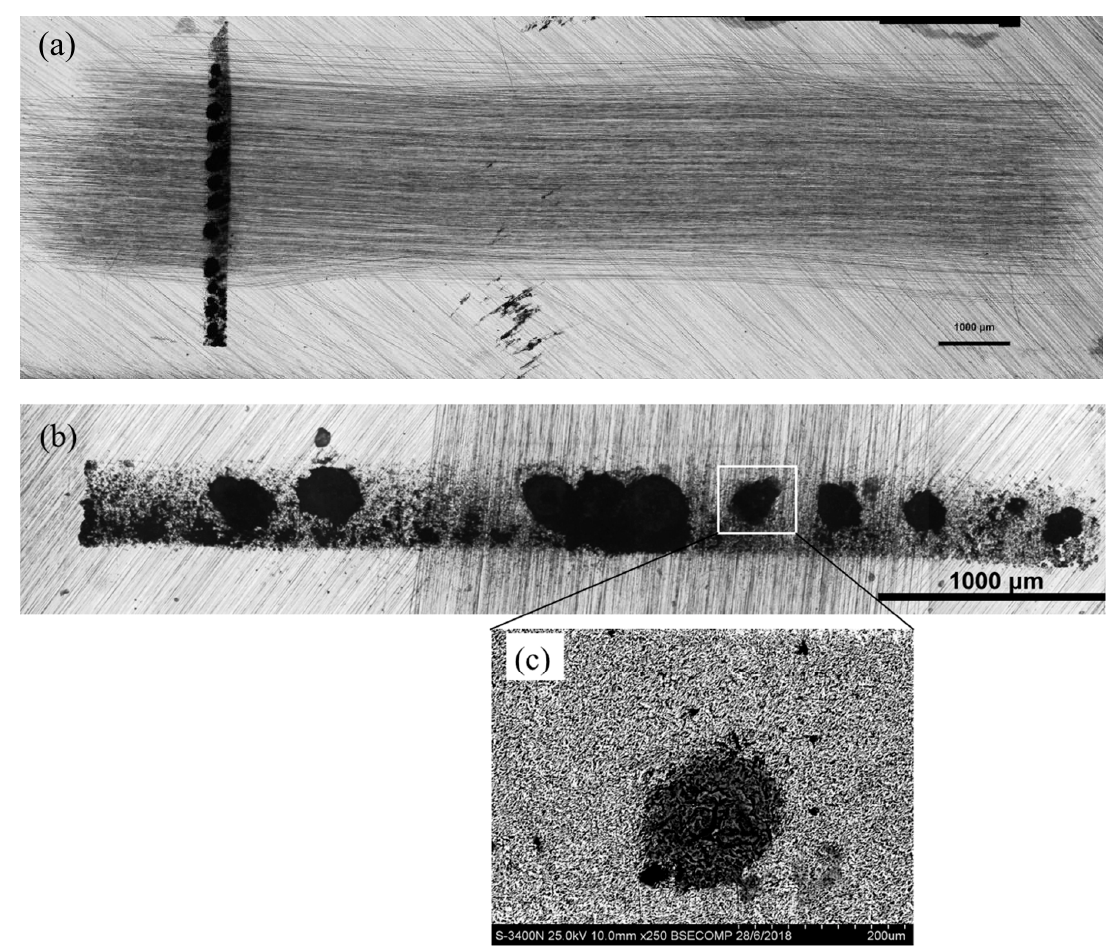
Figure 11. Corrosion morphology of FSP75% after polarization test.